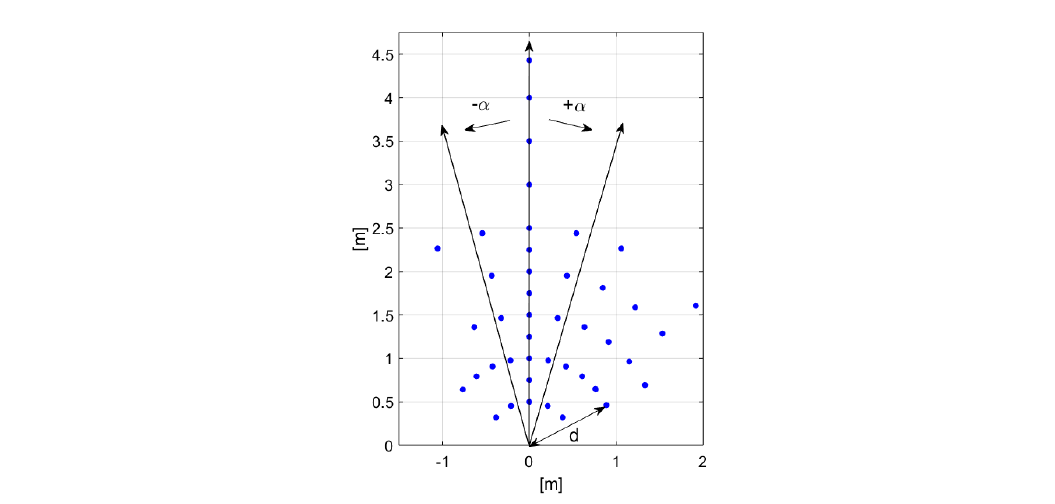
Figure 11. Person’s locations in the room considered for presence detection testing of a stationary